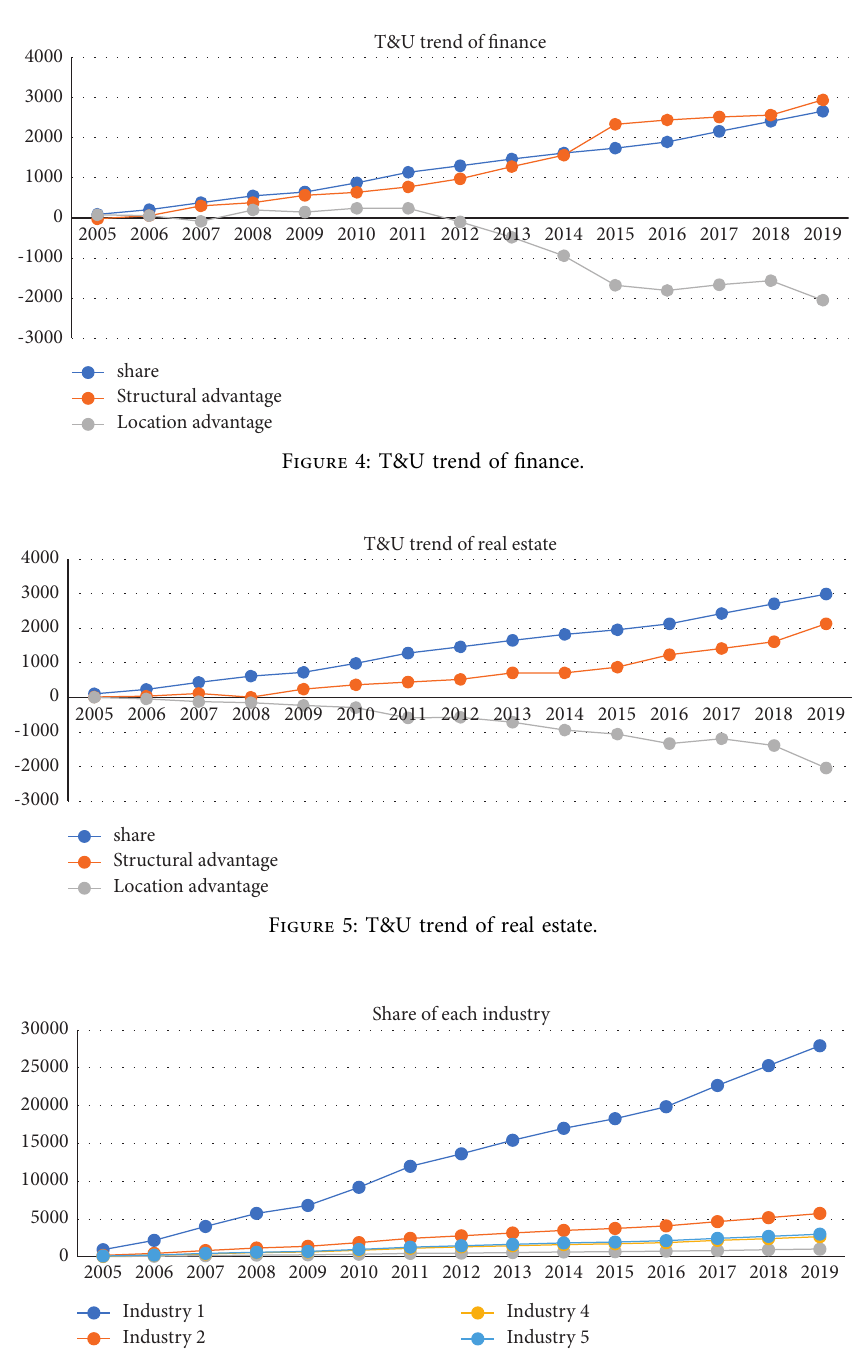
Figure 6: Share of each